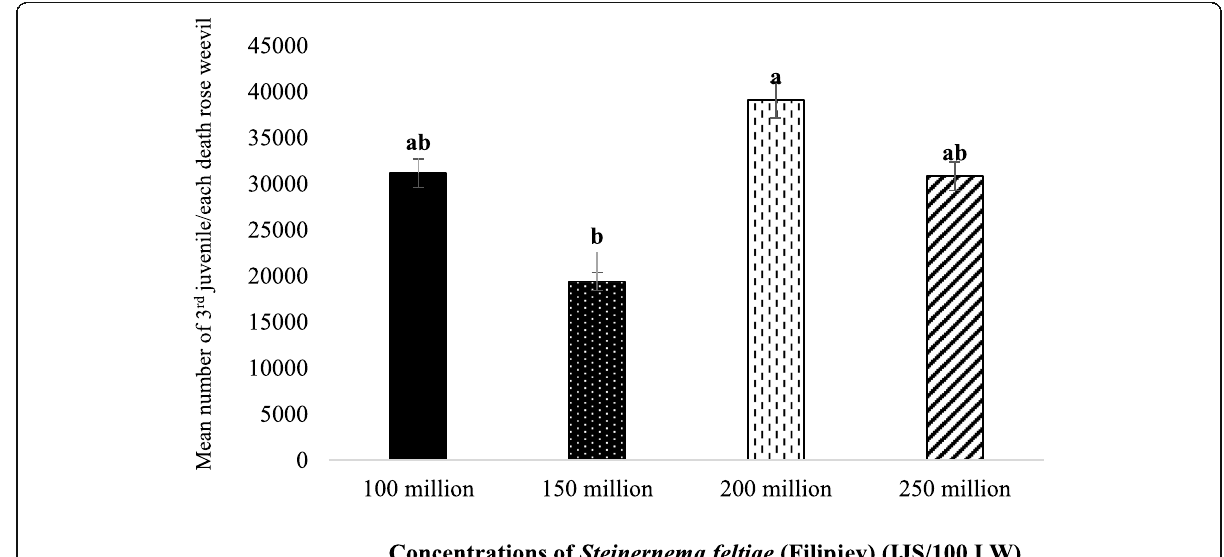
Fig. 1 Mean number of re-isolated 3rd juveniles from Mecorhis ungarica at different concentrations of Steinernema